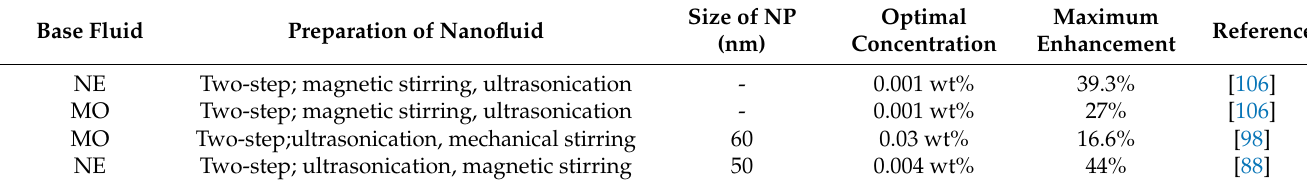
Table 5. Al 2 O 3 PDIV overview table. The size of NP refers to the nanoparticle core size, while the optimal concentration indicates the concentration value for which the maximal enhancement of PDIV was